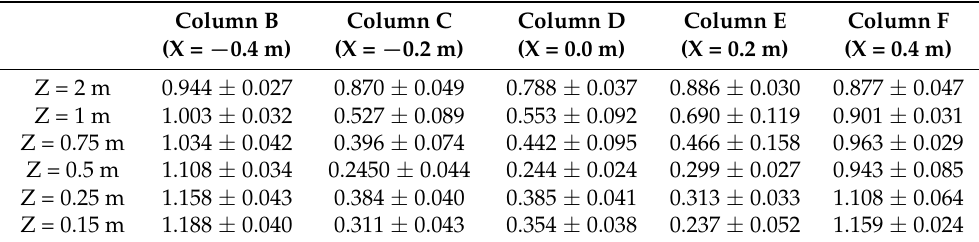
Table 2. Wind velocity measurement results (average of five measurements taken at the 4th height position).